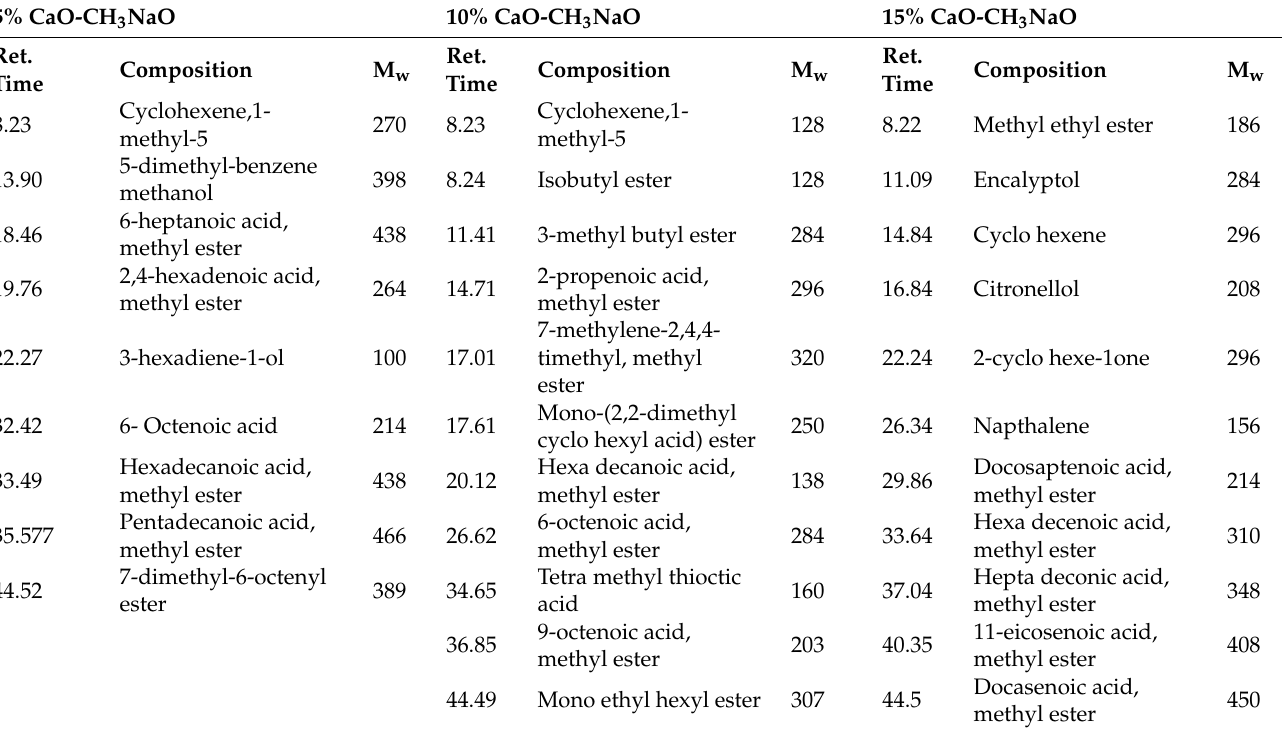
Figure 5. GC-MS analysis of sample B3. Table 1. Summary of GC-MS analysis of biodiesel produced using CaO-CH 3 NaO catalysts with different doping ratios.